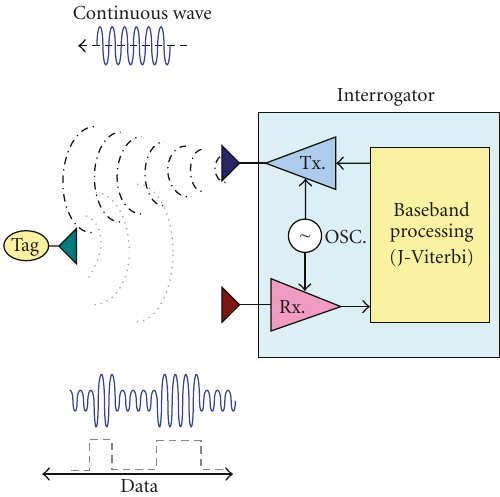
Figure 1: The block diagram of a RFID